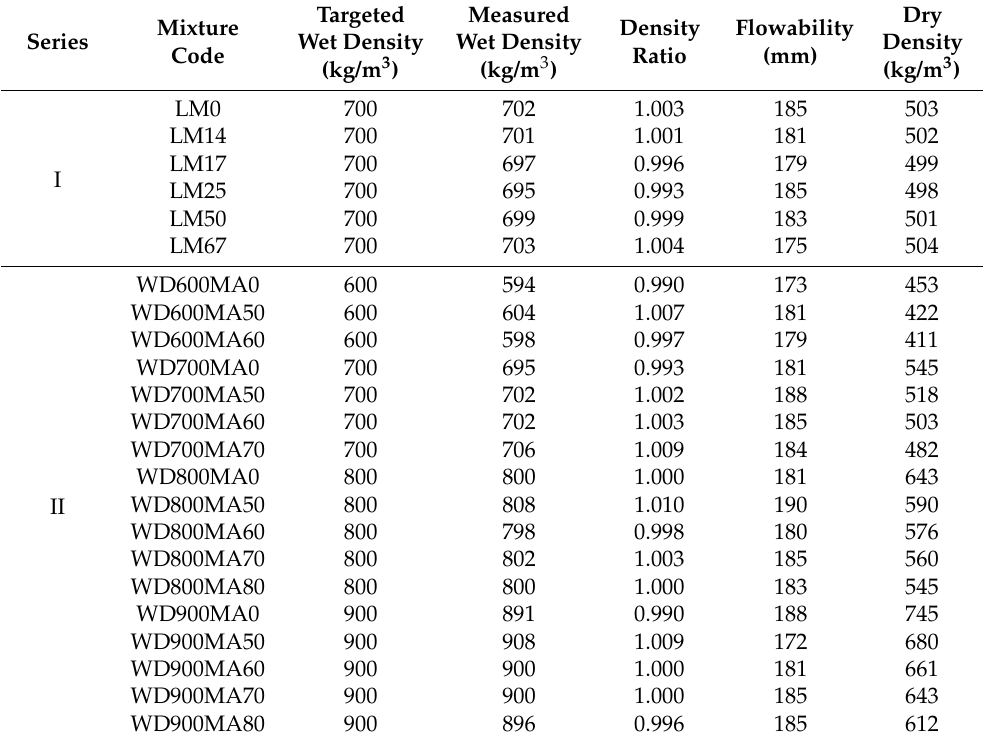
Table 4. Measured fresh properties and dry density of the